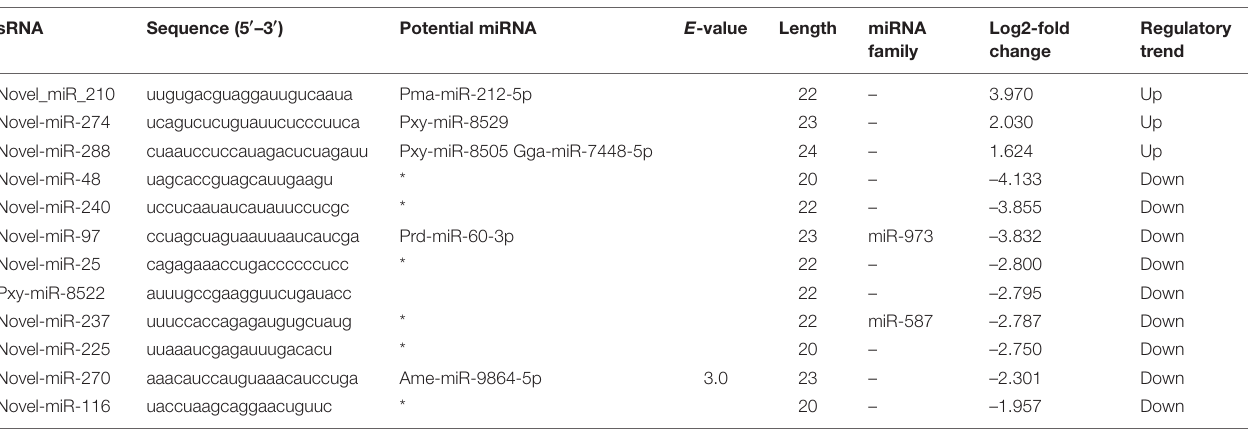
FIGURE 3 | Top 10 abundantly expressed known (A) and novel (B) miRNAs in both the resistant (Cry1S1000) and susceptible (G88) strains. Average expression values of top 10 abundantly miRNAs are presented. TPM, transcripts per million. TABLE 2 | Differentially expressed miRNAs in the Cry1S000 and G88